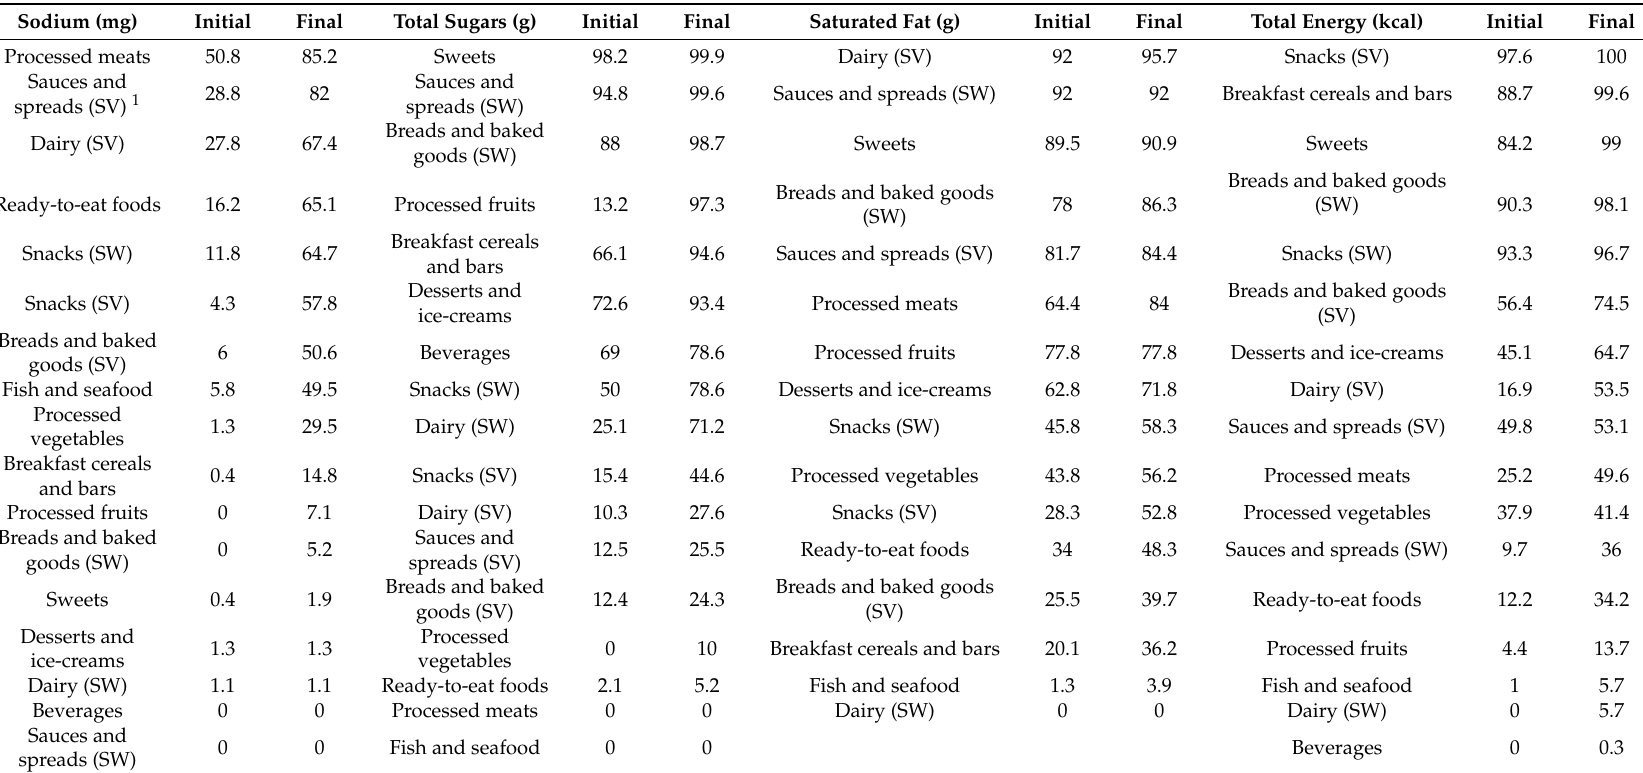
Table 4. Proportion of foods by food group that exceed the initial and final phase limits in rank order according to the final phase